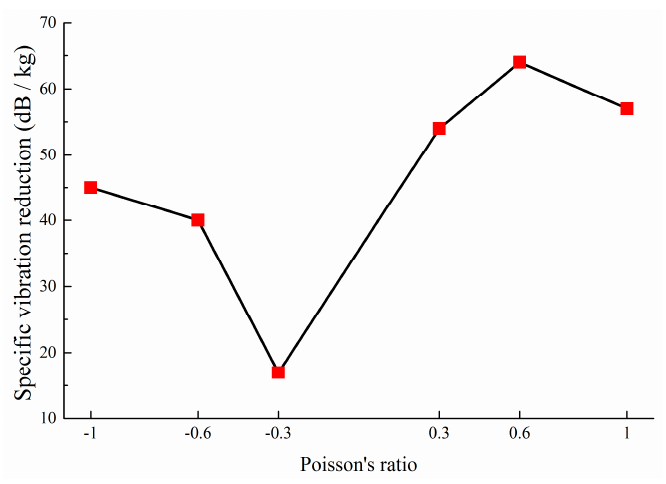
Figure 17. Lightweight effect on vibration reduction performance, corresponding to various PR metamaterials.